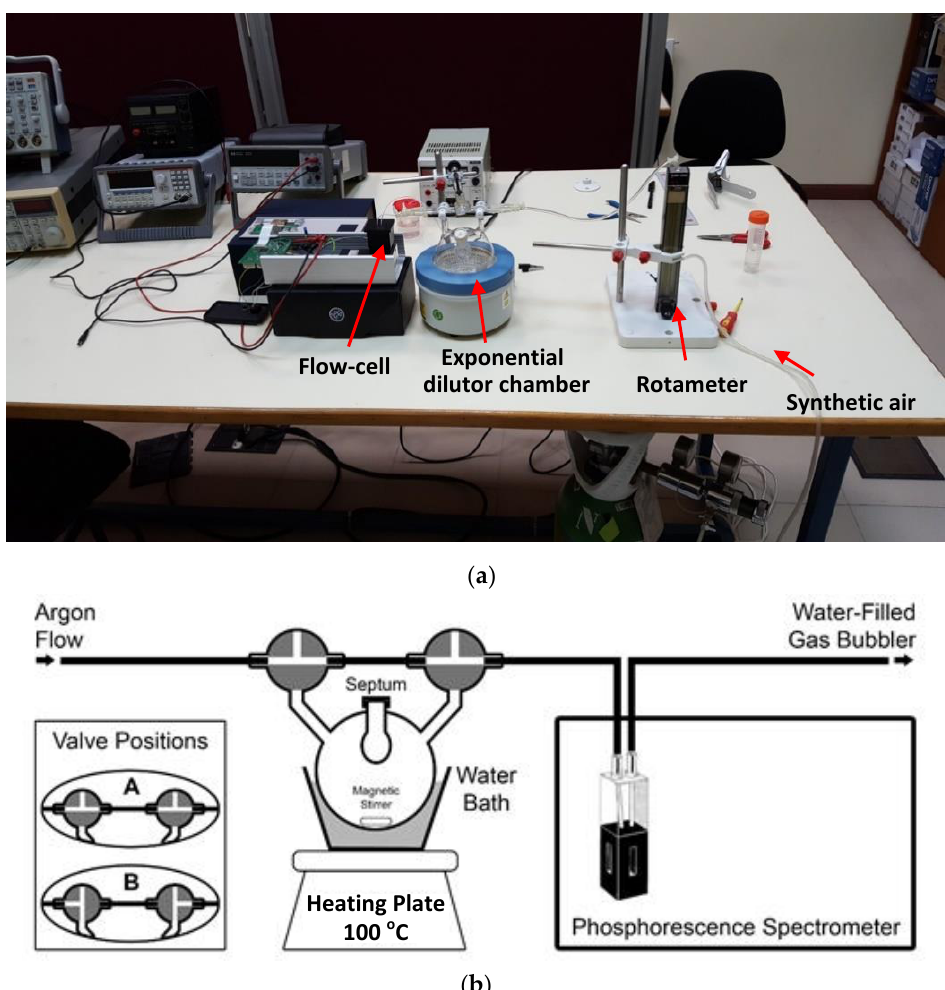
Figure 7. Experimental setup used to characterize the analytical performance of the phosphorimeter. ( a ) Picture of the assembled instrumental prototype showing the system used to generate air samples with known acetone concentrations. ( b ) Diagram of the exponential dilutor chamber.